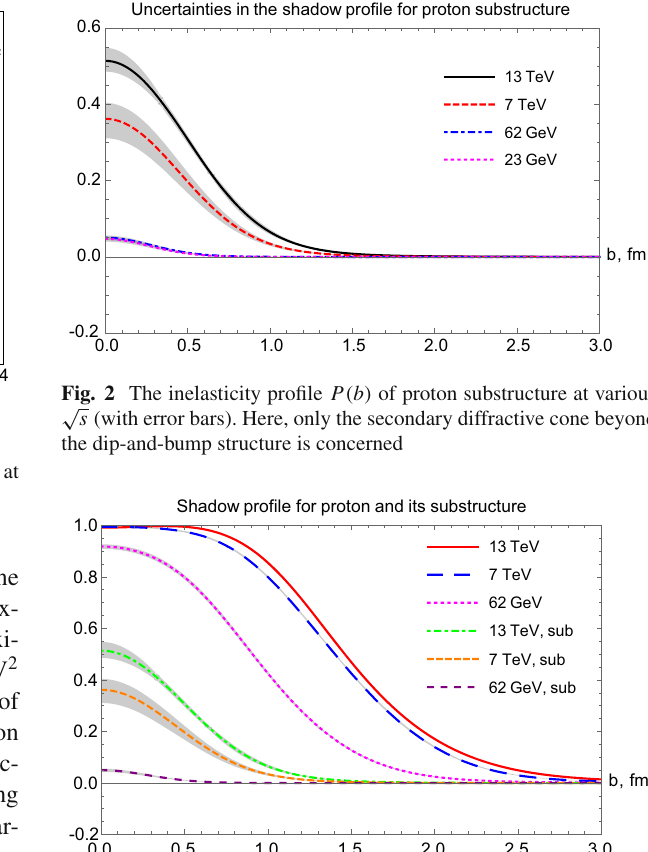
Fig. 3 The inelasticity profile P ( b ) of the proton and its substructure at various collision energies, including the error bars